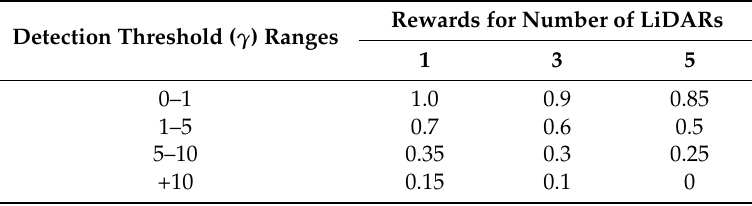
Table 1. Q-learning reward matrix for detection threshold.